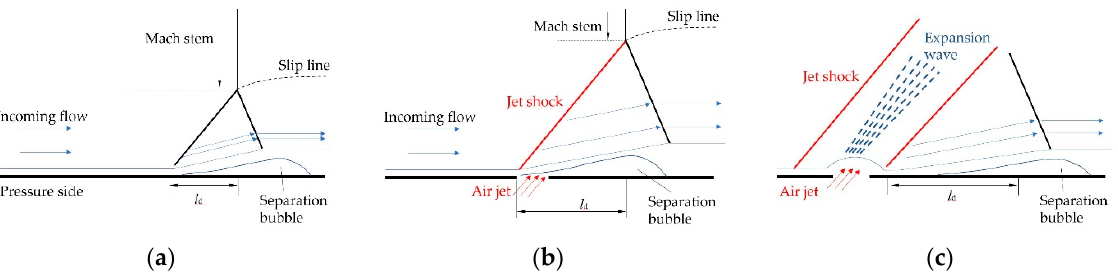
Figure 16. Simplified models of trailing-edge shock near pressure side: ( a ) no control; ( b ) air jet close to uncontrolled trailing-edge shock; ( c ) air jet far from uncontrolled trailing-edge shock.